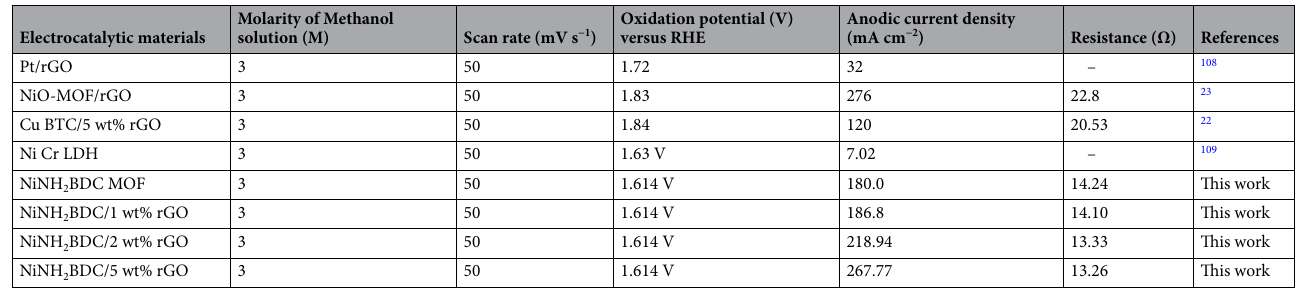
Table 5. The electrocatalytic activity of synthesized samples in comparison with reported